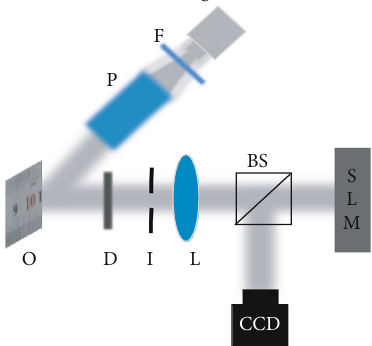
Figure 1: Schematic diagram of the experimental optical path of the FINCH